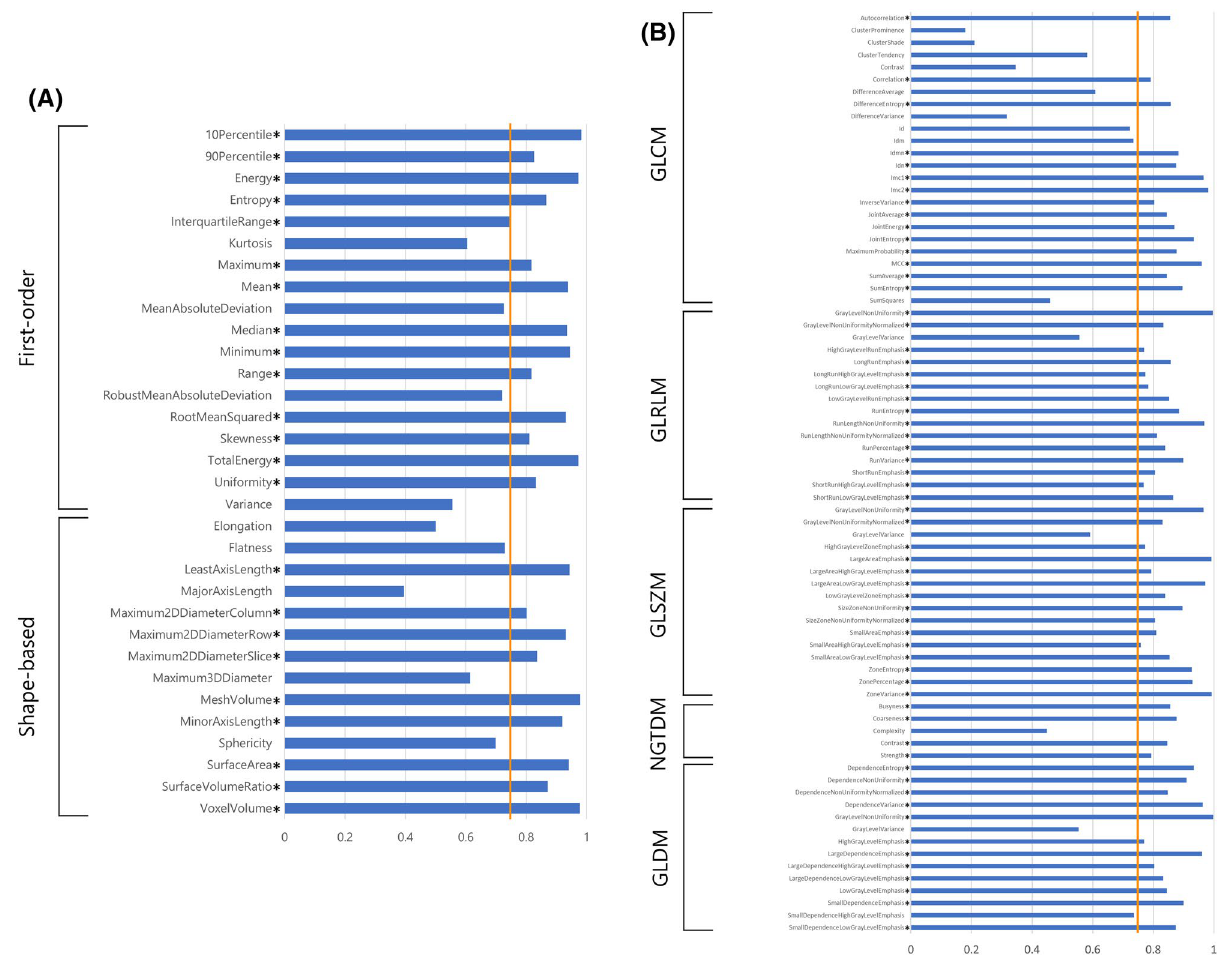
Figure 5. Intraclass correlation coefficient (ICC) values for radiomics features obtained by manual and automatic segmentation (first-order and shape-based features ( A ); high-order features ( B )). Asterisks indicate the features with good to excellent ICC values (ICC > 0.75; orange line). GLCM gray-level co-occurrence matrix, GLRLM gray-level run length matrix, GLSZM gray-level size zone matrix, NGTDM neighboring gray tone difference matrix, GLDM gray-level dependence matrix.